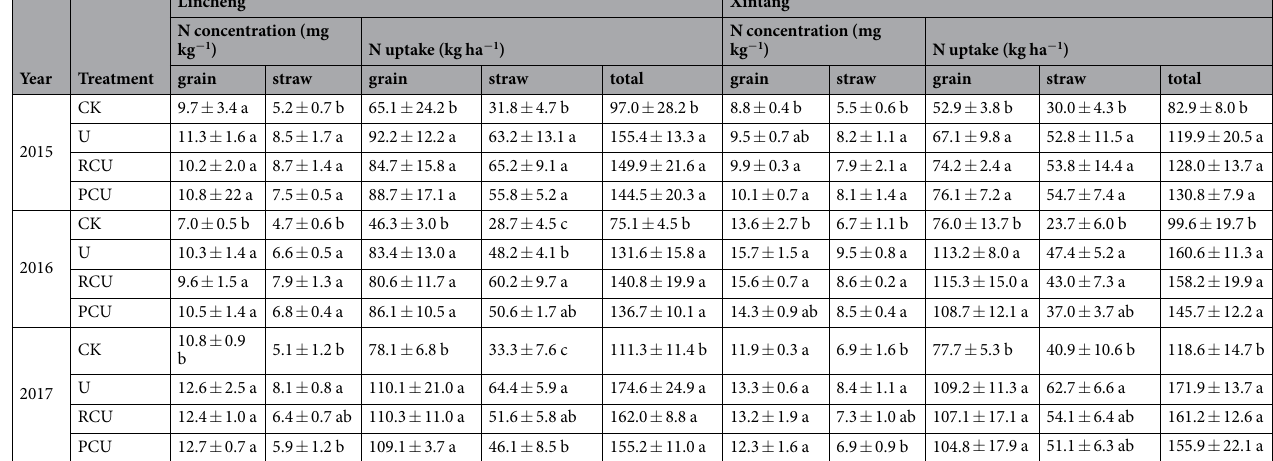
Table 3. The N concentration in and N uptake of rice were affected by the different treatments at the two experimental sites during the 2015 to 2017 rice growing seasons. The values are presented as the mean ± standard deviation (n = 3). Different letters in the same columns at the same site represent significant differences at the level of P < 0.05. CK, U, RCU and PCU represent no N application, conventional urea, resin- coated urea and polyurethane-coated urea, respectively.